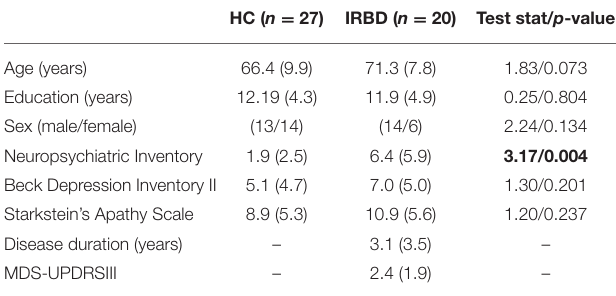
TABLE 1 | Demographic and clinical characteristics.